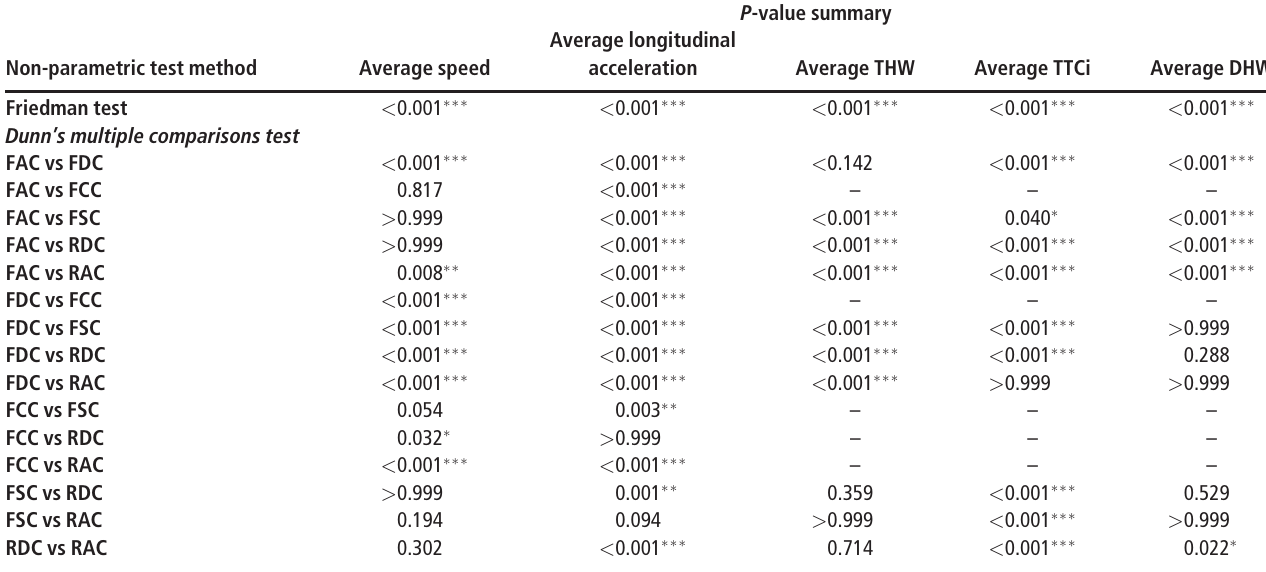
Table 11 Non-parametric test of one-way ANOVA results